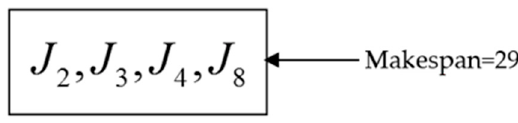
Figure 1. The makespan of the optimal solution.